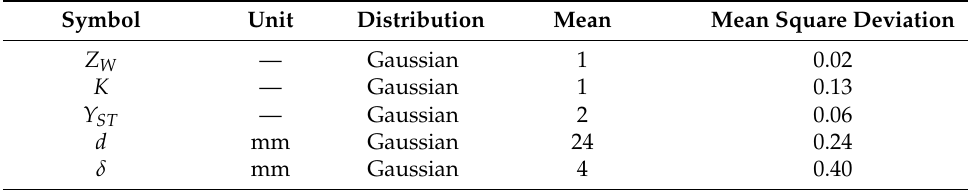
Table 4. Information of random